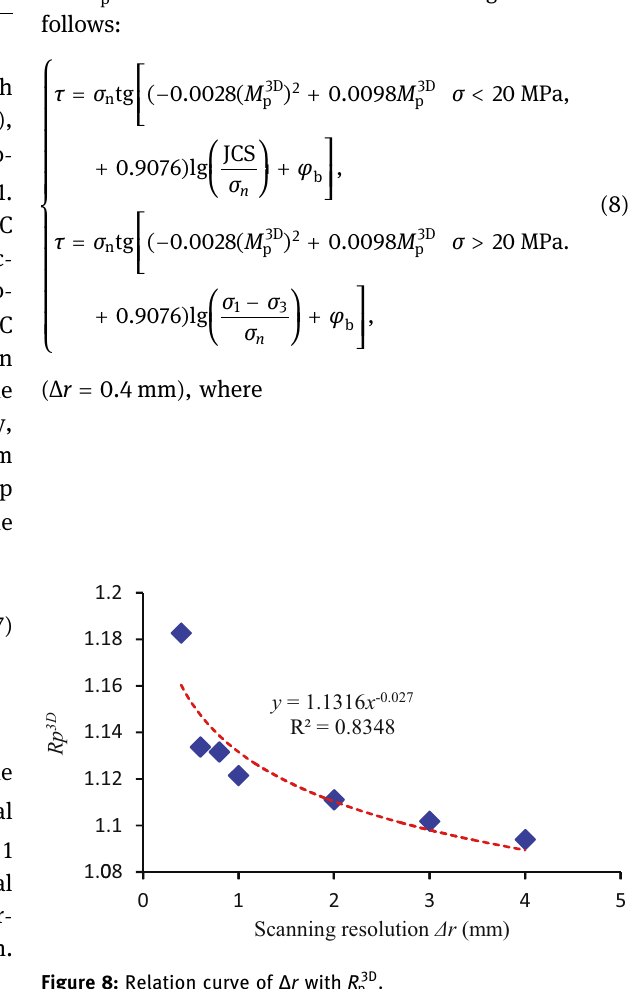
Figure 7: Model and grid of a 3D scanned model. ( a ) 3D model ( Δ r =